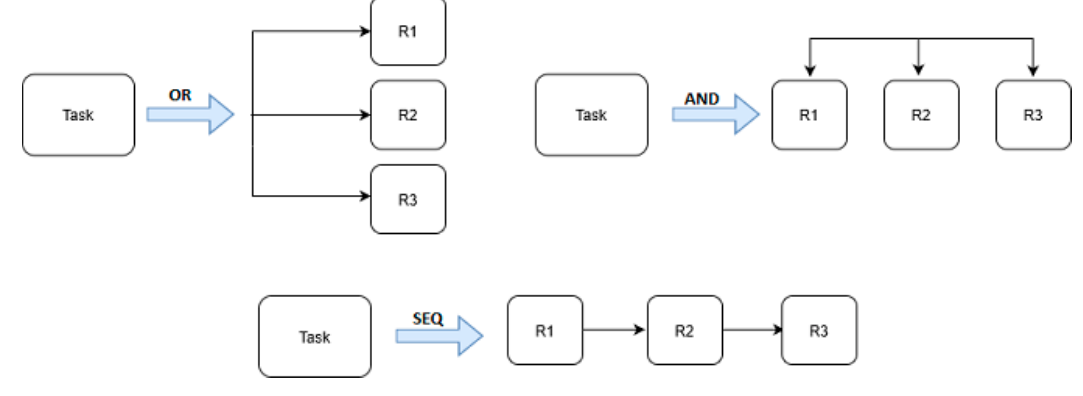
Figure 6. Task decomposition to atomic tasks.